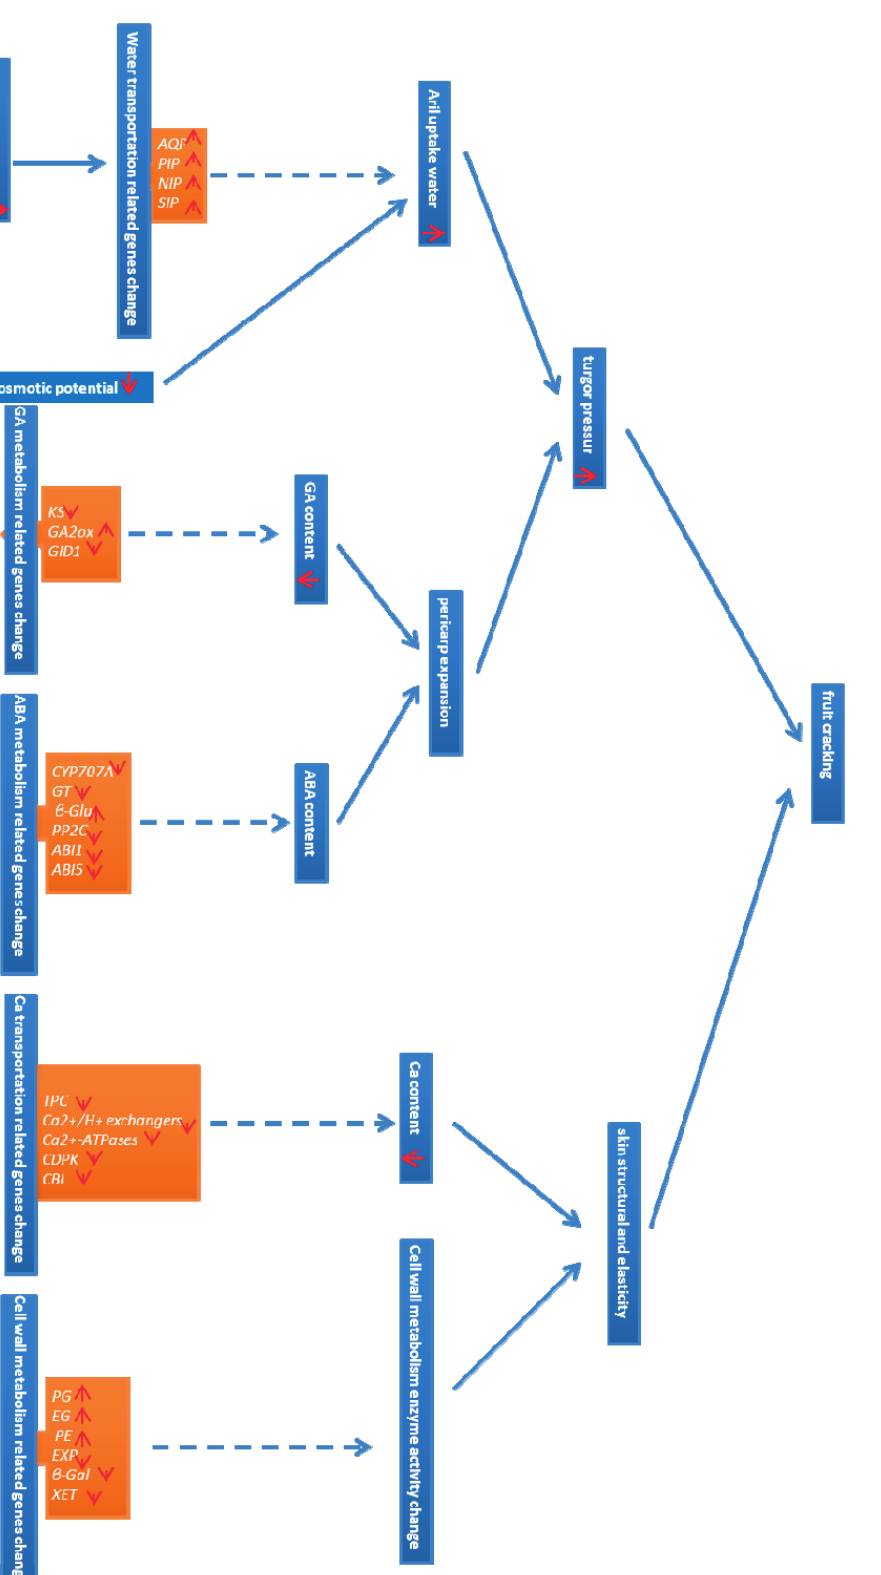
Figure 7. Hypothesized mechanisms of fruit cracking in